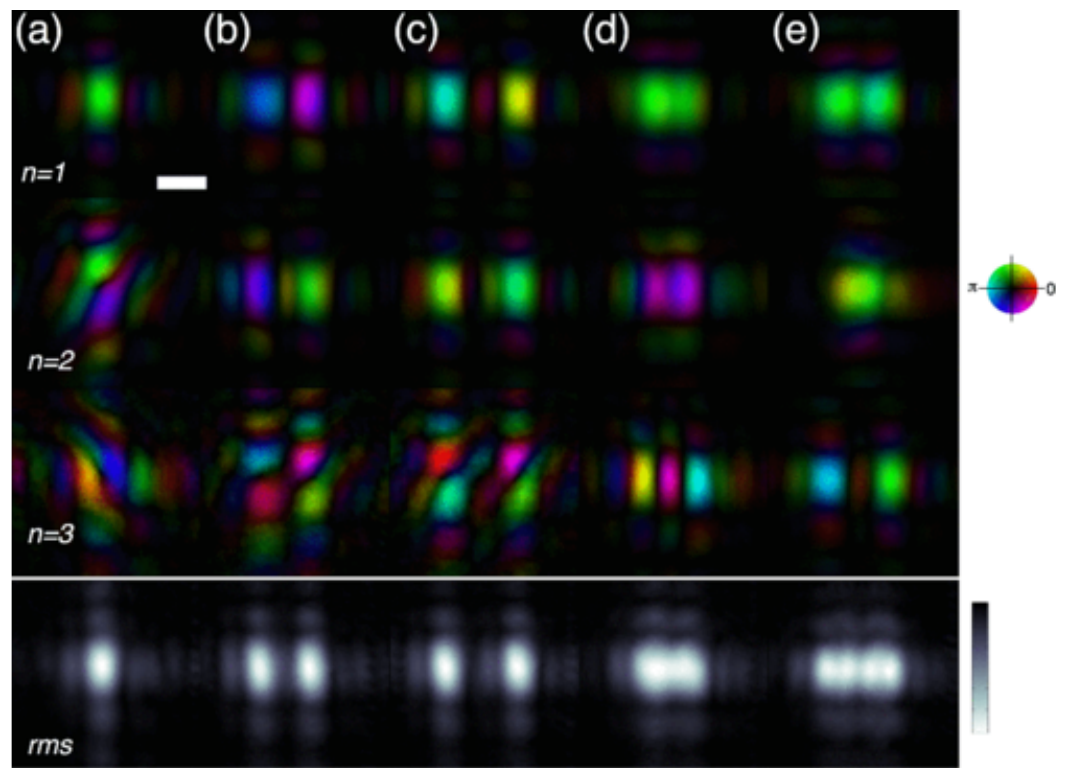
Figure 1. The first three ( n = 1, 2, 3) recovered probe modes for the cases of ( a ) a static sample; ( b ) a square wave with amplitudes 1 µ m and ( c ) 1.5 µ m; and ( d ) a sine wave with amplitudes 1 µ m and ( e ) 1.5 µ m. The bottom line also shows the square root of the summed intensity (rms, right column, linear scale) from five probe modes for the cases listed previously. The rms shows clearly how the probe forms can be manipulated using a vibrating sample. The scale bar is 1 µ m. The vibration frequency is selected to be 1 Hz with exposure of 6 seconds per position. Figure adapted from Ref [9], reprint permission granted, 2014 American Physical